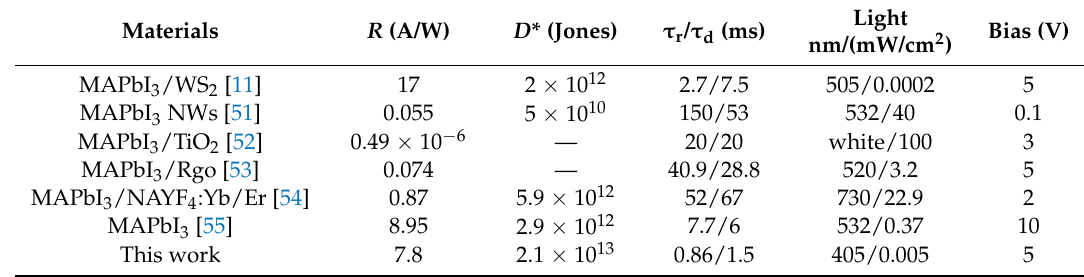
Table 3. Photo response performance comparison between this work and other MAPbI 3 -based photodetectors.